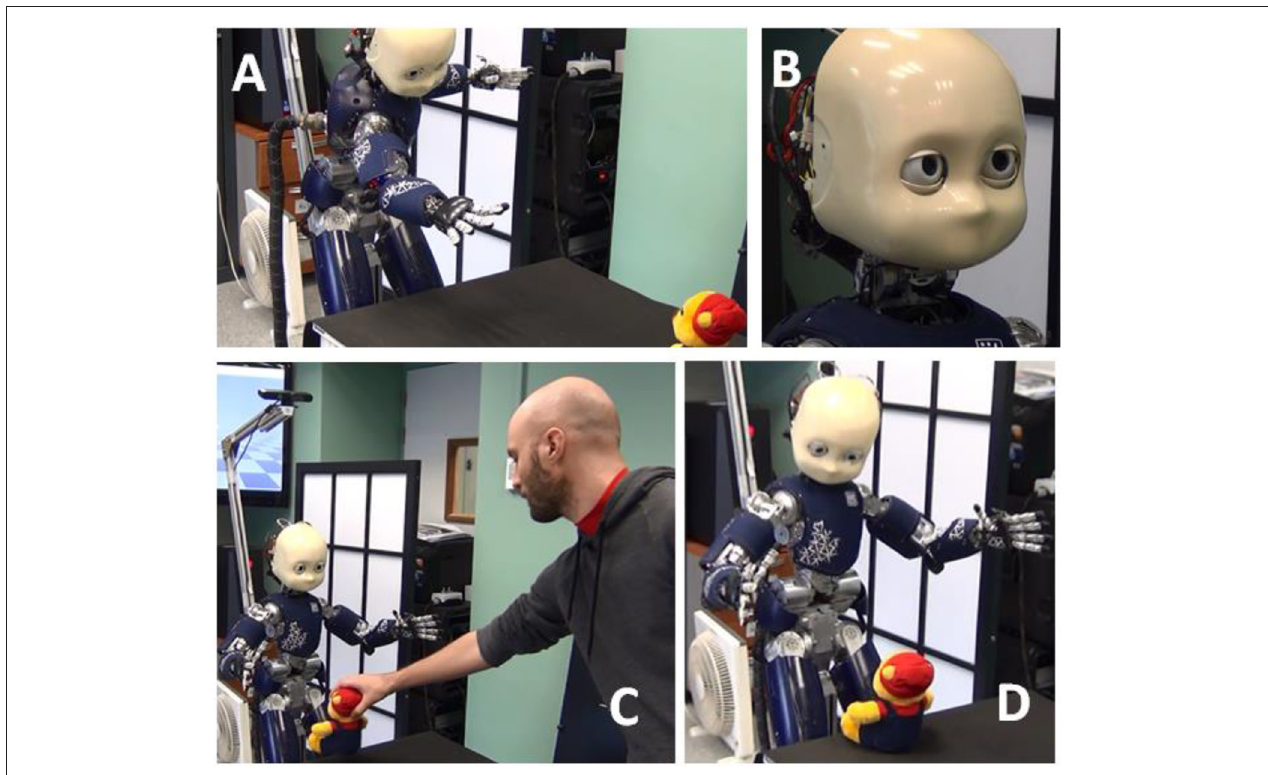
FIGURE 6 | iCub interacting with the human. The iCub interacting with the human during the complication-resolution scenario. (A) iCub wants the Winnie and attempts to grasp it, and fails. (B) After identifying an alternative method to achieve its goal, iCub asks the human to give it the Winnie. (C) The human then gives the iCub the Winnie. (D) The goal is fulfilled, iCub has the Winnie. This interaction populates the autobiographical memory (ABM) providing the meaning pole for learning the narrative